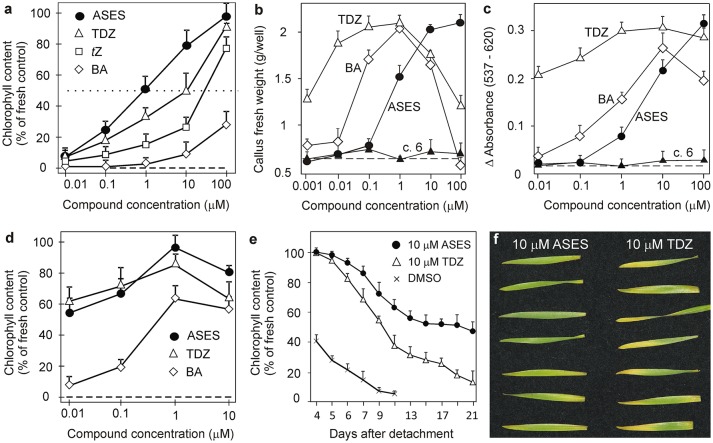
Evaluation of biological activities of selected compounds in classical cytokinin bioassays. The activity of ASES is compared with the activity of BA and TDZ. (a) Wheat leaf senescence assay performed in the dark (5 days). The dotted line indicates where the chlorophyll content in the leaves is 50% of that of fresh control leaves. The IC50 values were determined at this threshold. (b) Effect on growth of cytokinin-dependent tobacco callus. (c) Effect on dark betacyanin synthesis in Amaranthus caudatus cotyledon-hypocotyl explants. Graphs a–c are representative examples of compound biological activities obtained in one assay. Error bars show s.d. of the mean for five replicate determinations. c. 6 means compound 6. (d) Arabidopsis leaf senescence assay performed in the dark (12 days). Error bars show s.d. of the mean for two independent assays, where each value consist of four replicates. (e) Time-dependent progress of chlorophyll degradation in wheat leaf senescence assay and (f) appearance of the leaves on the 17th day. Error bars show s.d. of the mean for four replicate determinations. In (a,d,e), 100% represent chlorophyll content in fresh control leaves. Dashed lines indicate values obtained for the control treatment (DMSO control) with no added compound.